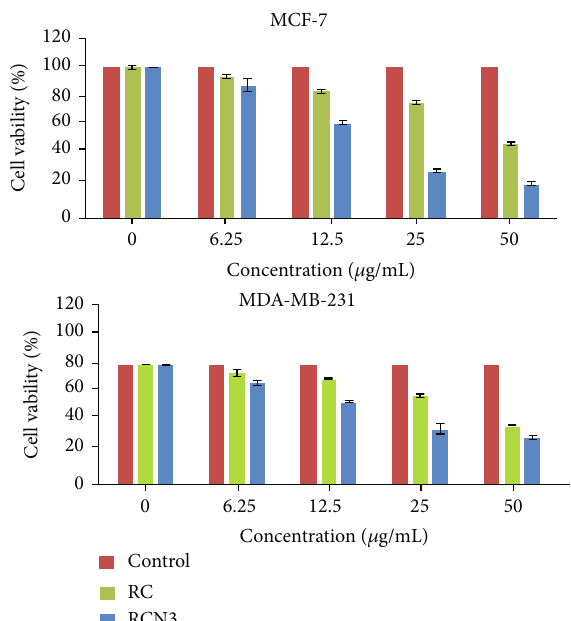
Figure 6: Percent cell viability of pure RC and optimized nanosponge (RCN3) against MDA-MB-231 and MCF-7 breast cancer cell